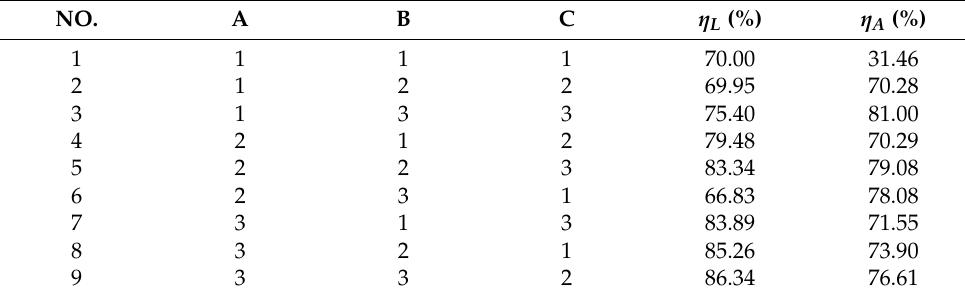
Table 5. Experimental scheme and analysis results based on η L .